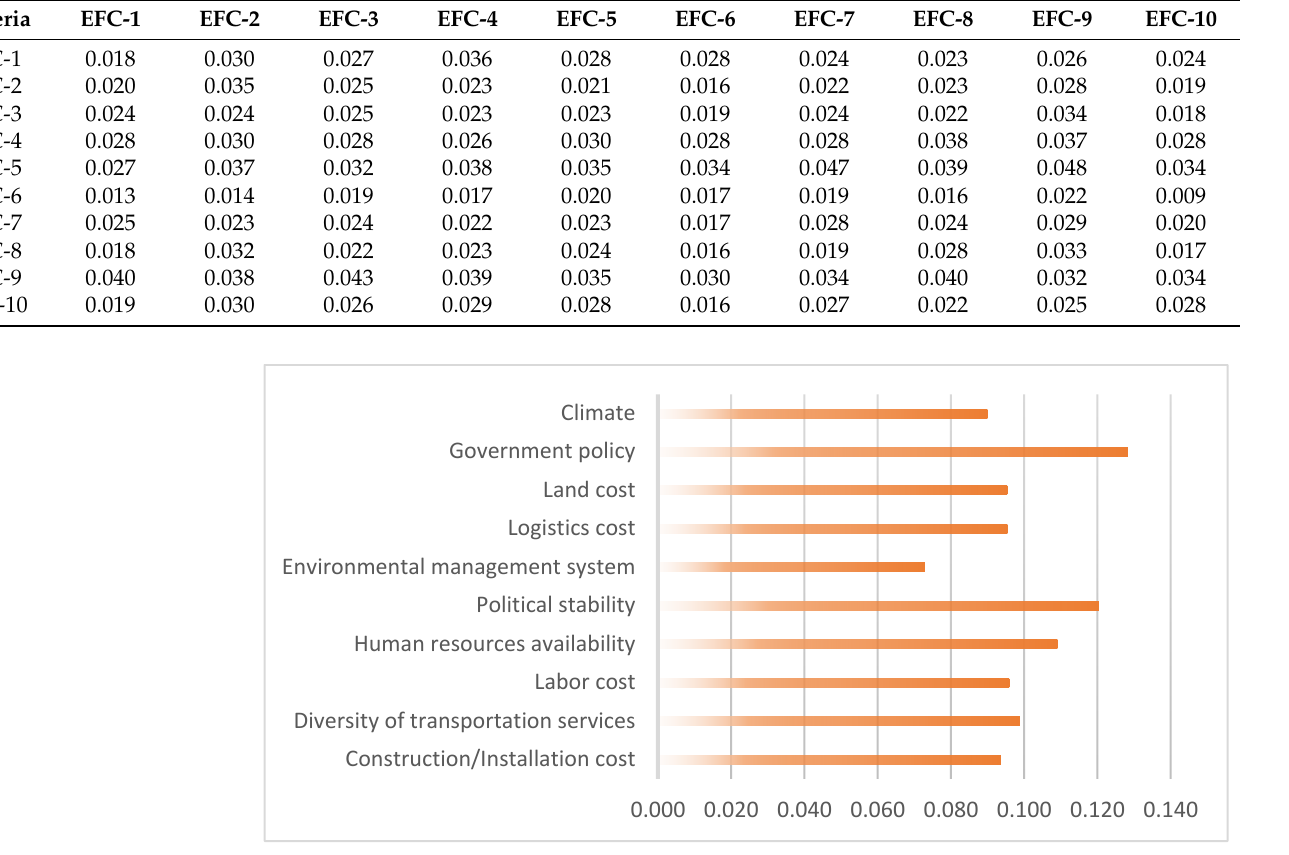
Figure 4. Criteria weighting results.